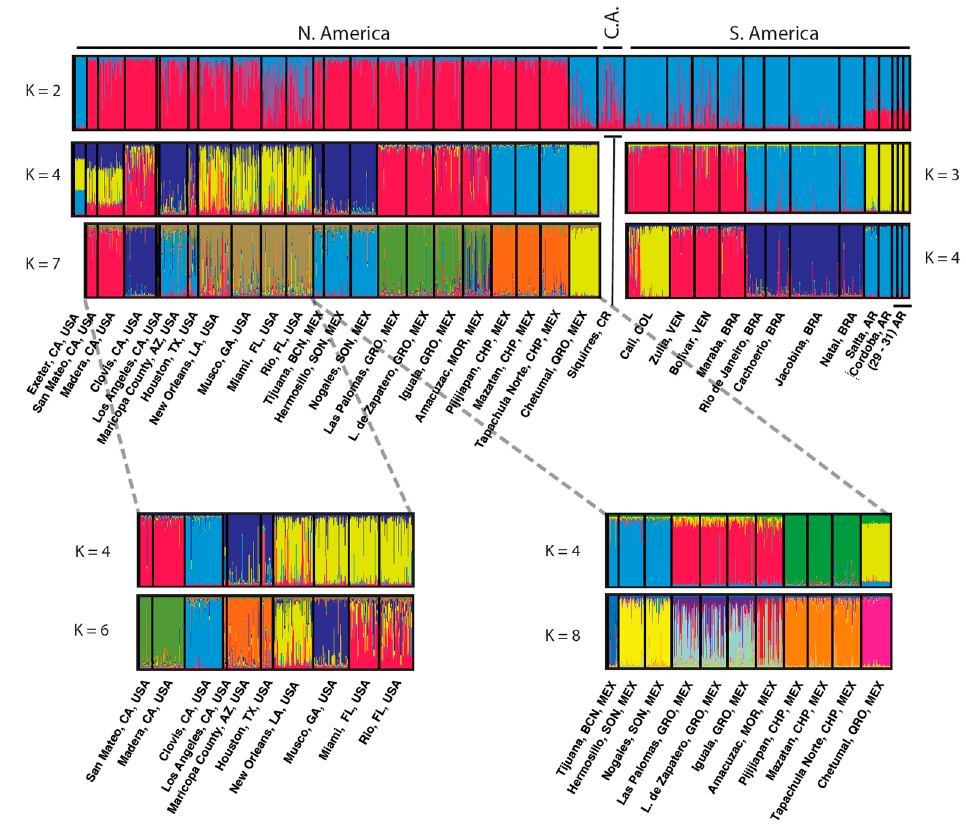
Figure 3. Genetic structure of population samples of Aedes aegypti from the Americas based on microsatellites. Bayesian STRUCTURE plots [10] are shown for different groups of populations. K is the number of subpopulations assumed. From [20].